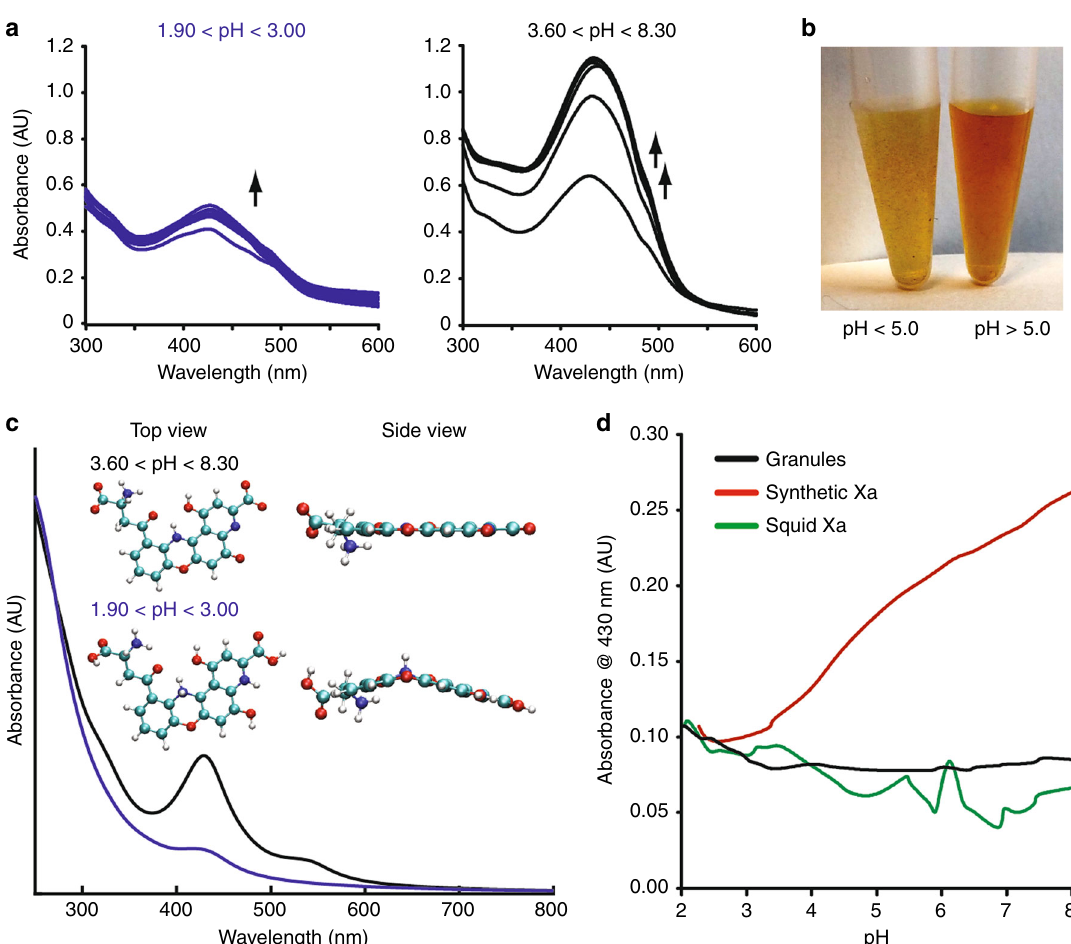
Fig. 7 pH-dependent color change of compound Xa. a Variations in absorptive behaviors of Xa associated with an increasing pH. b A bright- fi eld image of the two visible colors displayed by compound Xa at high (>5.00) and low (<5.00) pH values. c Proposed molecular structures of Xa and their corresponding absorption spectra calculated under neutral (designated with a neutral charge, black line) and acidic (designated with a + 3 charge, blue line) conditions. d The absorbance intensity (collected at 430 nm) associated with varying the pH in the synthetic Xa compared to granules and the pigment-extracted from the granules (squid Xa)